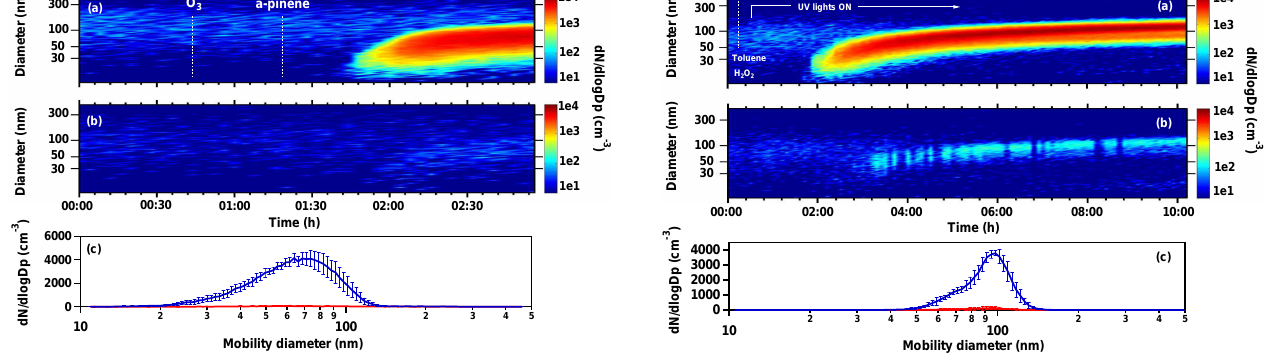
Figure 2. Time evolution of particle number size distribution dur- ing the photooxidation of toluene, measured after (a) the bypass line set at 25 ◦ C and (b) the TD set at 400 ◦ C. The color scale rep- resents particle number concentration. (c) Average particle number size distribution (from 07:00 to 09:00; 40 scans, 3min time span) of toluene SOA for chamber measurements, at 25 ◦ C (blue), and TD loss-corrected measurements at 400 ◦ C (red) (Exp. 1, Table 1).Ver- tical lines correspond to confidence